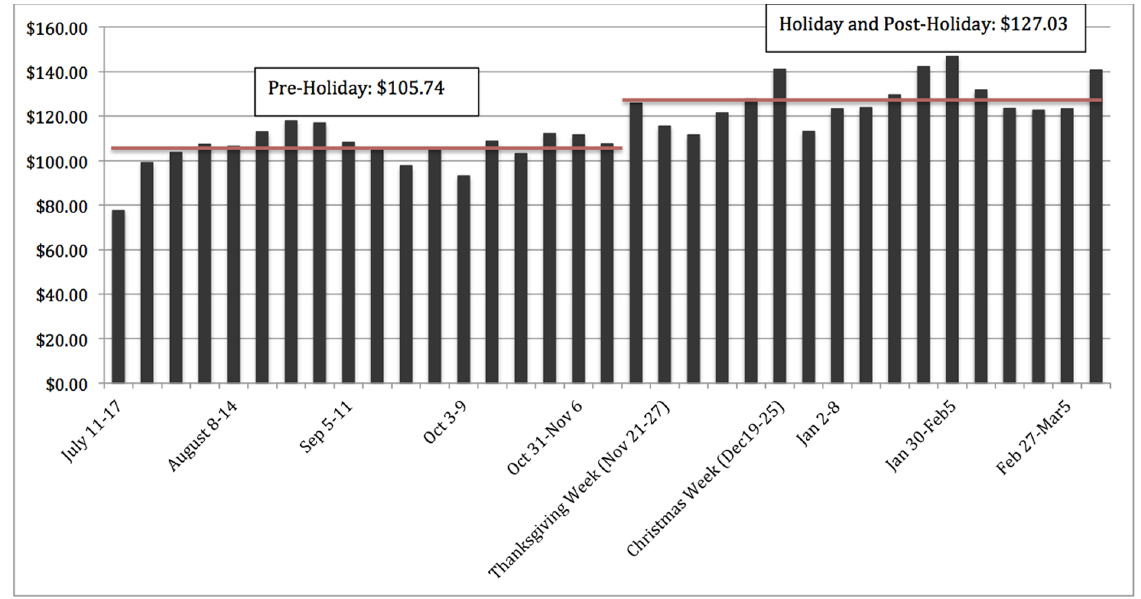
Figure 1. Average Weekly Expenditures Increase During Both the Holiday and Post-Holiday Seasons. Weekly average expenditures were plotted out for the duration of the study. Thanksgiving fell on week 20 of the study and Christmas fell on week 24.